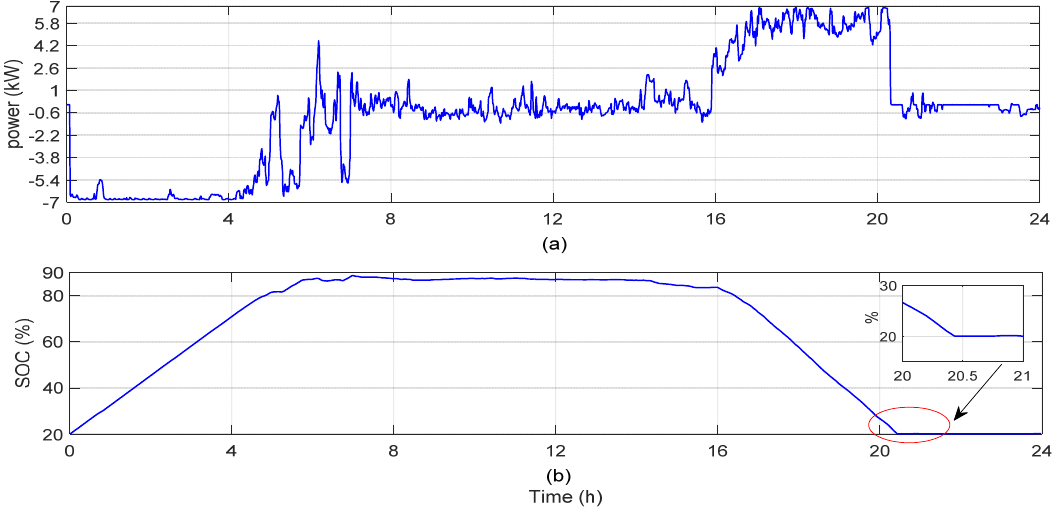
Figure 15. ( a ) Optimal settings sent to the BESS using 1 min sample time; ( b ) The measured state of charge of the BESS.